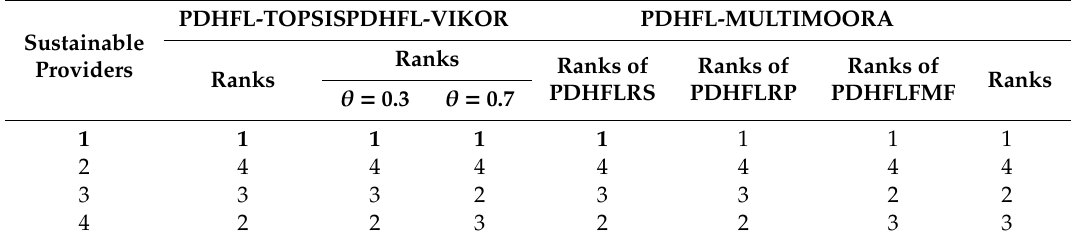
Table 9. Comparison of PDHFL-MULTIMOORA and other existing PDHFL-MAGDM methods. Sustainable Providers